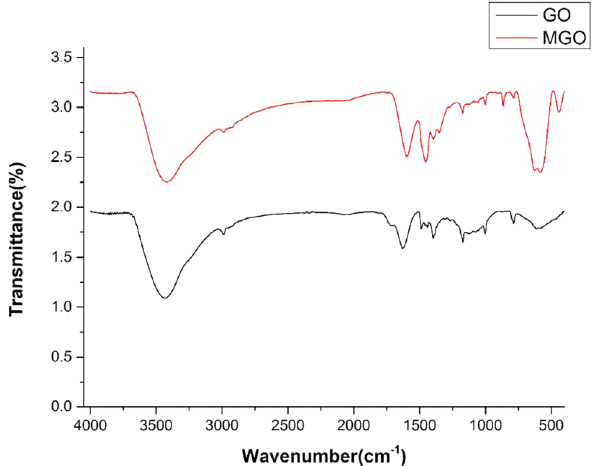
Figure 2: FT - IR spectrum of GO and Fe 3 O 4